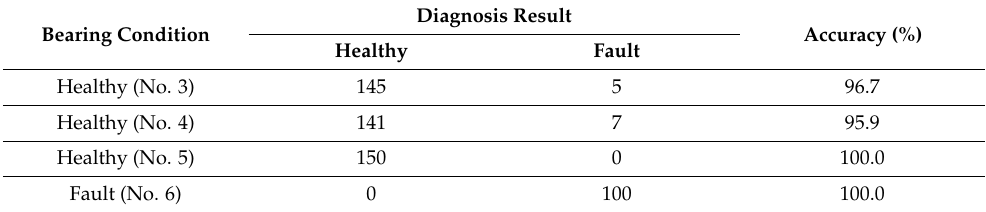
Table 3. Diagnosis result based on Random